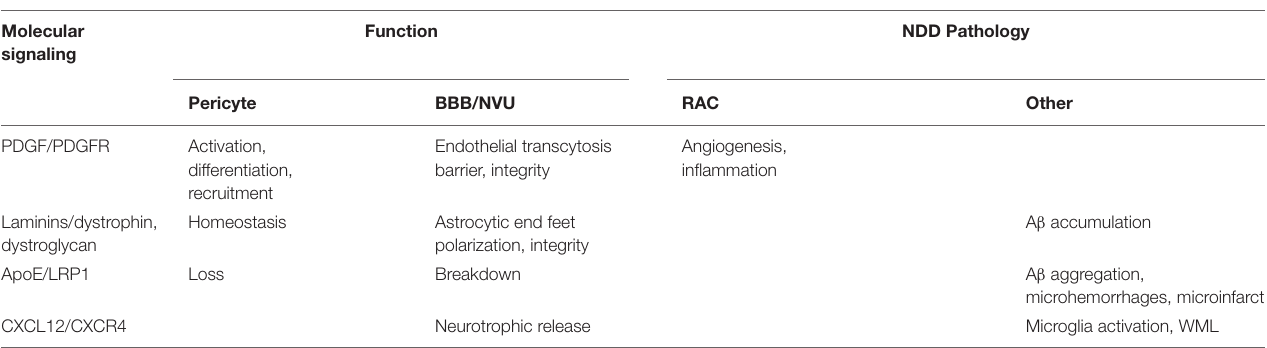
TABLE 2 | Astrocyte and pericyte biological